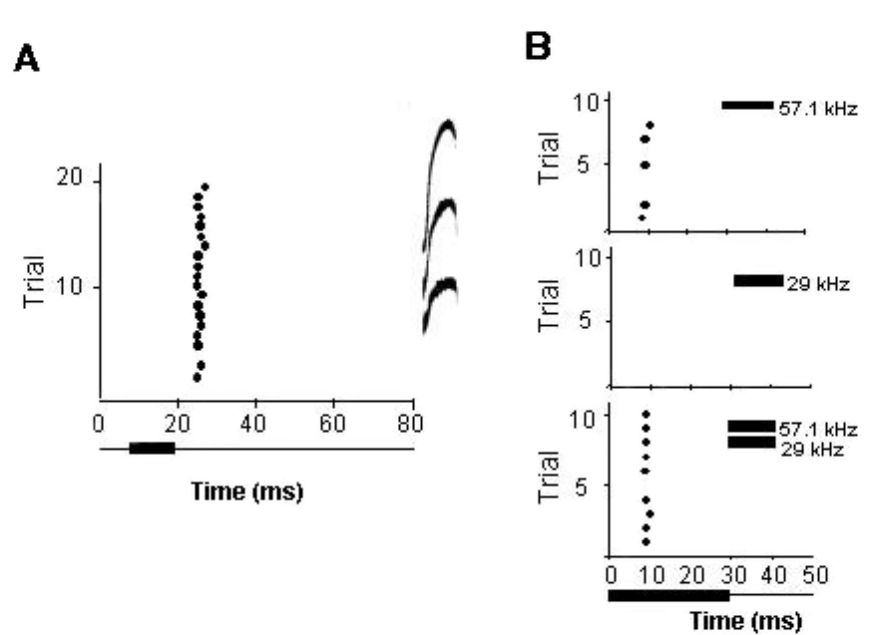
Fig. 1 – Responses of a single neuron in the IC to a communication call and tone stimuli. The single unit shown here responded to only one of fourteen different communication calls. A: Raster plot of the neuron’s response to its preferred vocalization (three-harmonic, upward frequency modulated sweep call is shown in the insert). Twenty emissions of the call were presented to the single unit. B: Raster plots showing combination-sensitive response of the neuron. The neuron responded in a facilitatory manner to the combination of the 57 kHz and 29 kHz tones. Ten emissions of the stimuli were presented. Black bars under raster plots indicate onset time and duration of